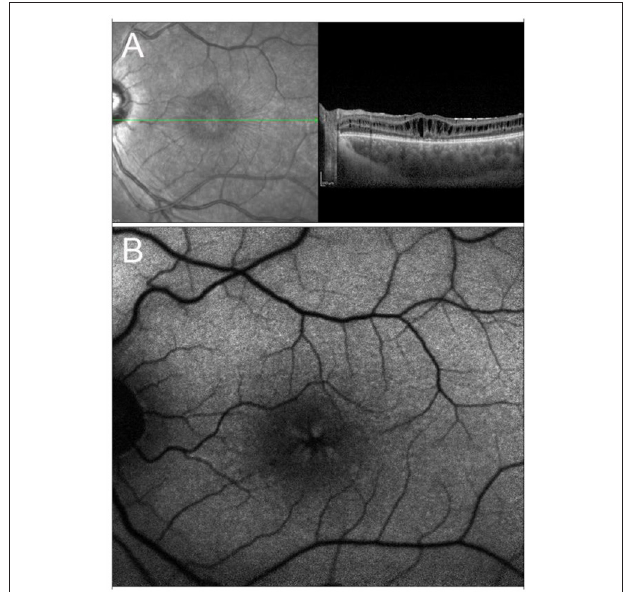
FIGURE 4 | Multimodal imaging in X-linked retinoschisis. (A) Combined infrared reflectance imaging and structural OCT. Note the spokewheel pattern of folds radiating out from the fovea, which corresponds to the foveal schitic cavities seen on structural OCT. (B) Fundus autofluorescence also shows the spokewheel pattern due to the overlying foveal schisis.